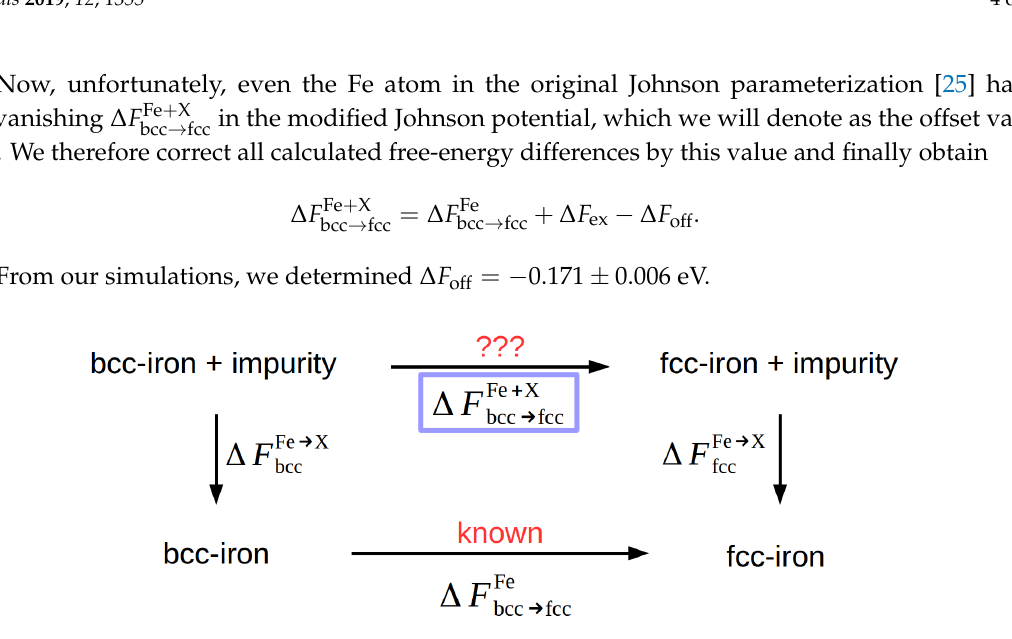
Figure 3. Thermodynamic cycle for the determination of the free-energy difference between the bcc and fcc phase in Fe containing an alloying element